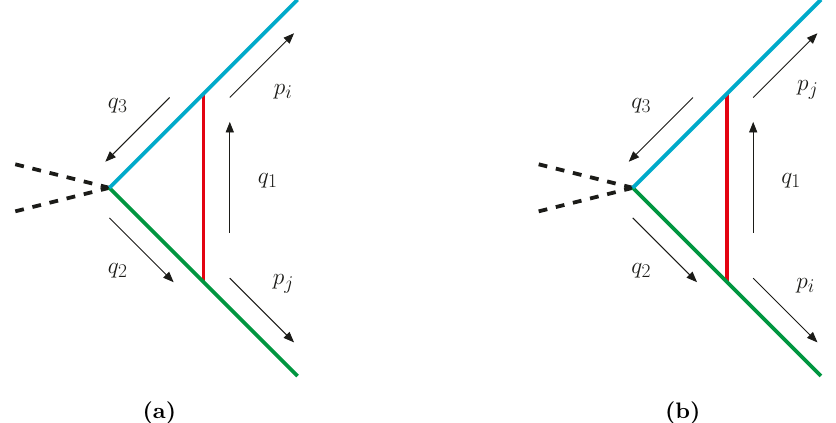
Figure 3. Diagrams associated with three-point functions coming from the reduction of the virtual amplitude. The meaning of the colours is the same of figure 1. The triangle of panel (b) is obtained by exchanging p in the triangle of panel i ↔ p j